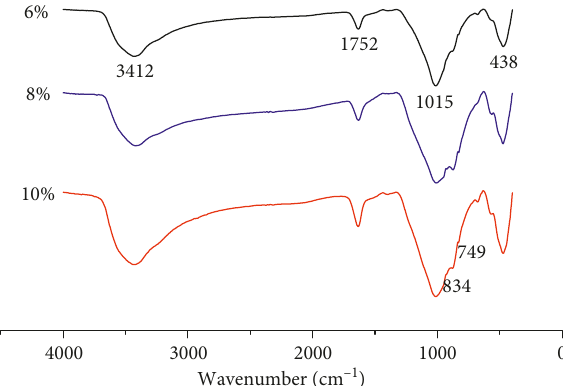
Figure 6: FTIR of copper-nickel slag and CNSCM with different SS contents and a curing time of